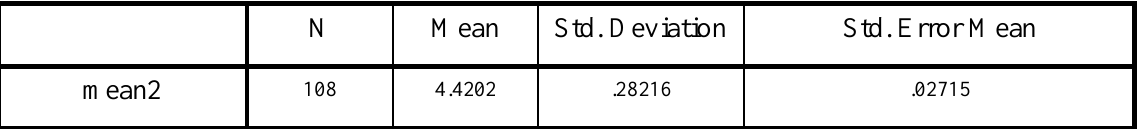
Figure 14. Descriptive statistics of the variable in sub-hypothesis B